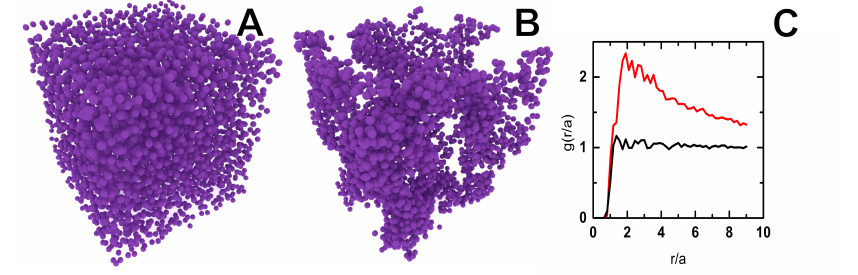
Figure 7. Computer-reconstructed visualizations of a sample with particle coordinates obtained from three-dimensional confocal microscopy data. The field of view is 67 µ m × 67 µ m × 75 µ m. ( A ) a liquid dispersion of particles, φ ≈ 0.15, at 25 ◦ C in 50 wt % Sucrose with 10 mM NaCl; ( B ) a colloidal gel of the same dispersion at 50 ◦ C; ( C ) calculated radial distribution functions normalized for particle size, a , for gel (red, A ) and liquid dispersion (black, B